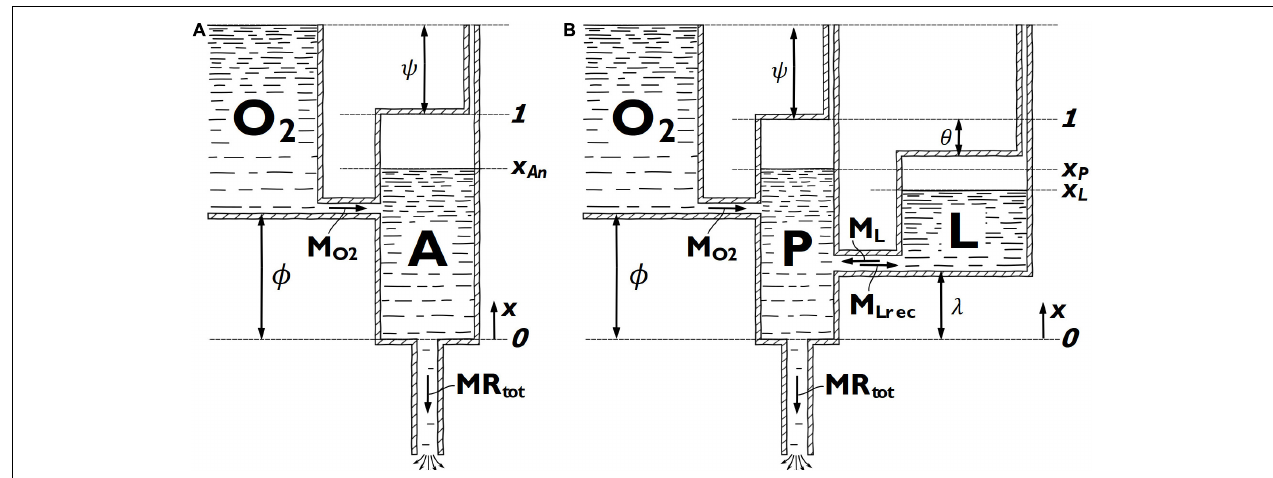
FIGURE 3 | Diagrammatical representations of (A) the critical-power derived two-tank model (2TM) and (B) the adjusted Margaria-Morton three-tank model (3TM). The x-coordinate is used to express fluid surface level positions in each tank.